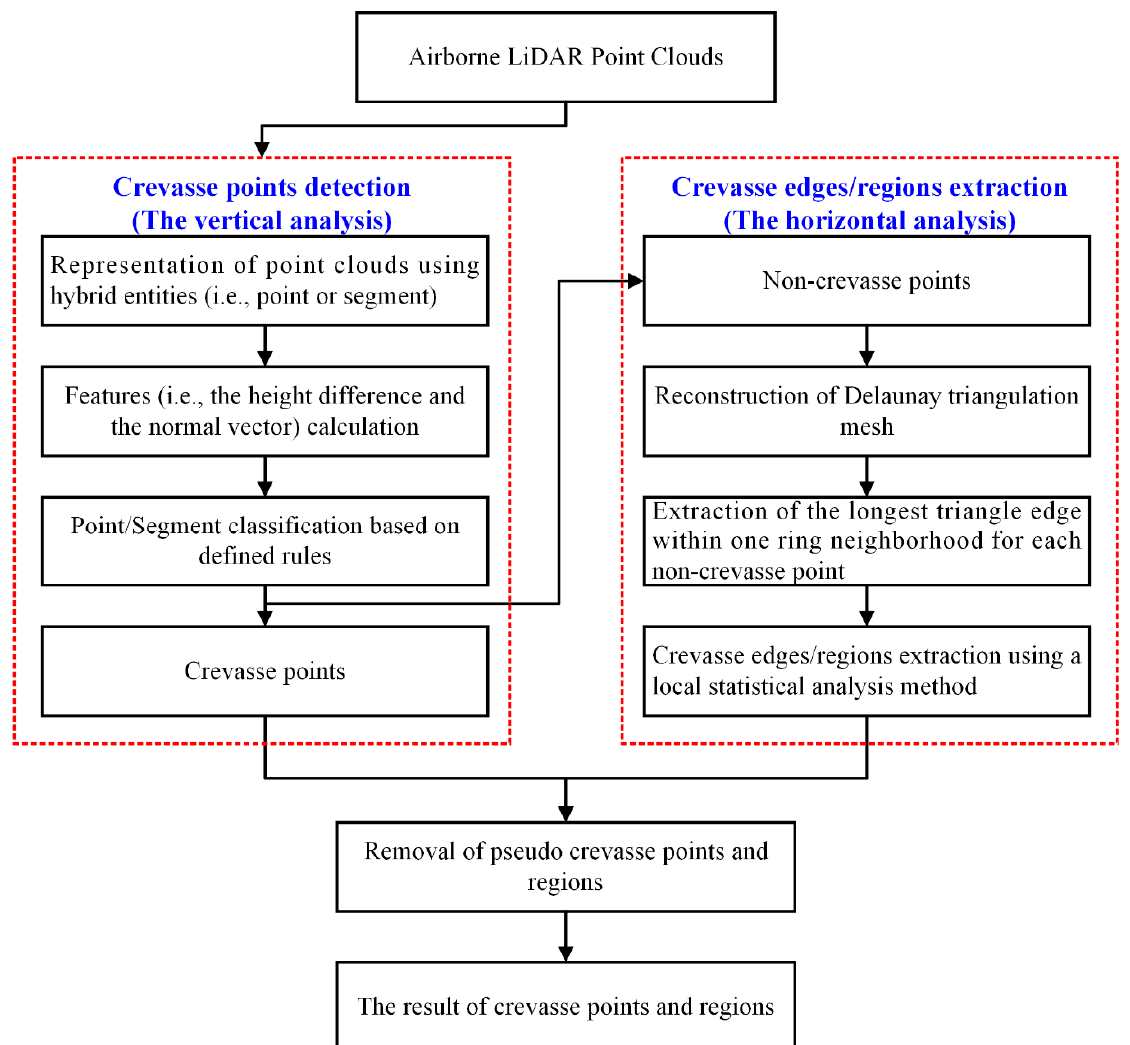
Figure 3. Workflow of the proposed bidirectional analysis method.